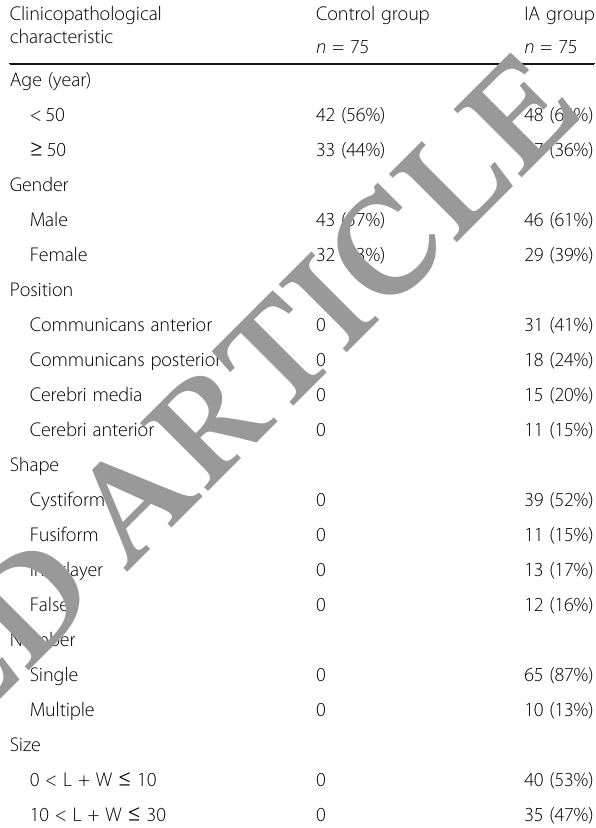
Table 2 Comparison of general information of study